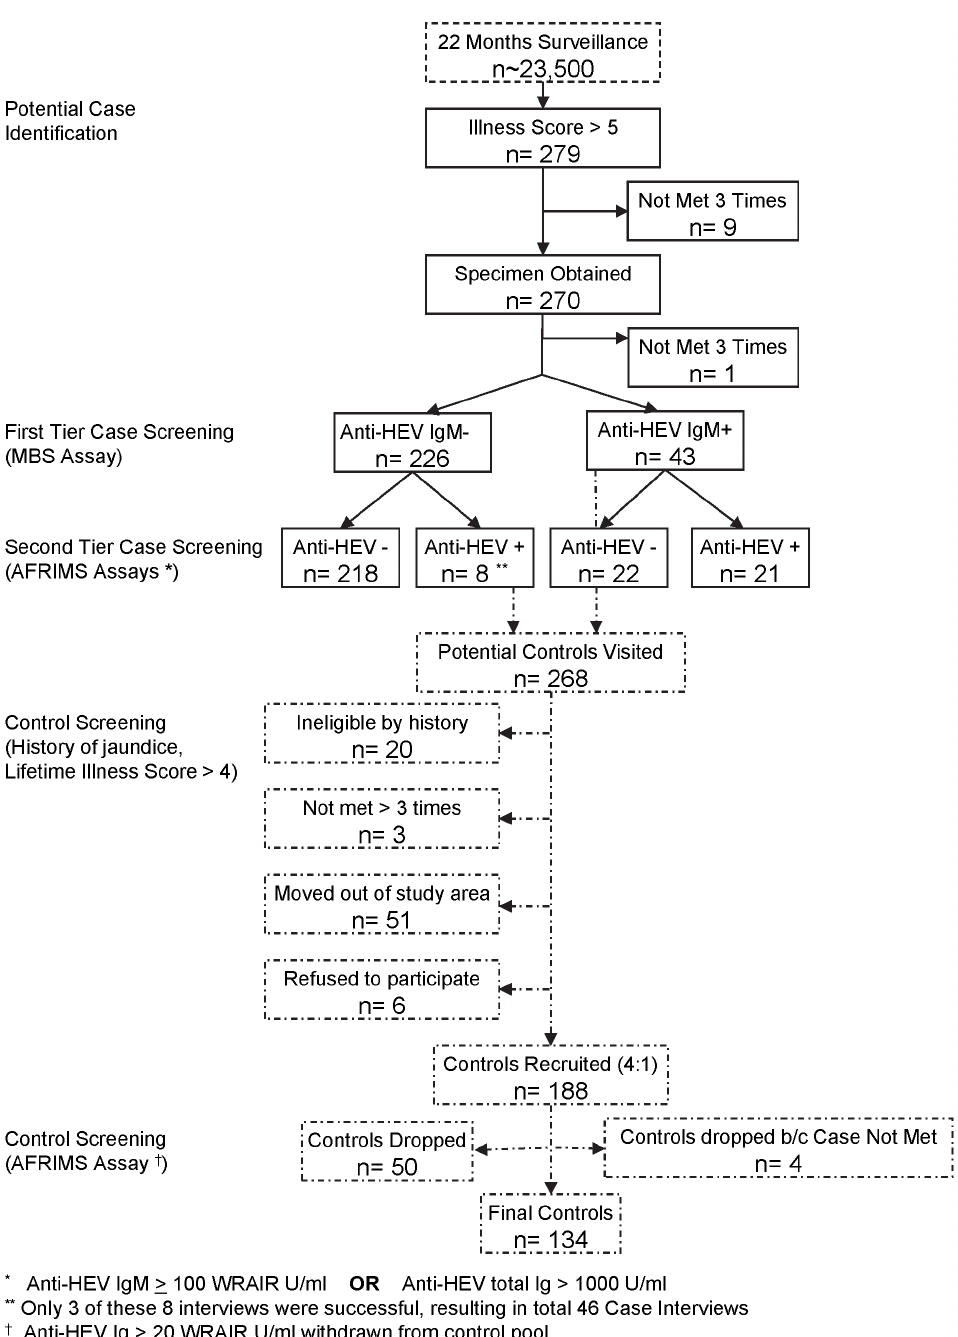
Figure 2. Case and control screening and selection diagram.